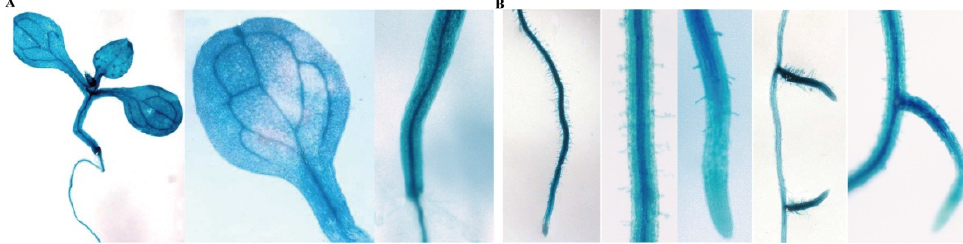
Figure 4. Tissue expression patterns of GmTIP1;6 promoter in transgenic Arabidopsis . GUS staining for the aerial ( A ) and underground ( B ) parts of proGmTIP1;6-GUS transgenic Arabidopsis seedlings.